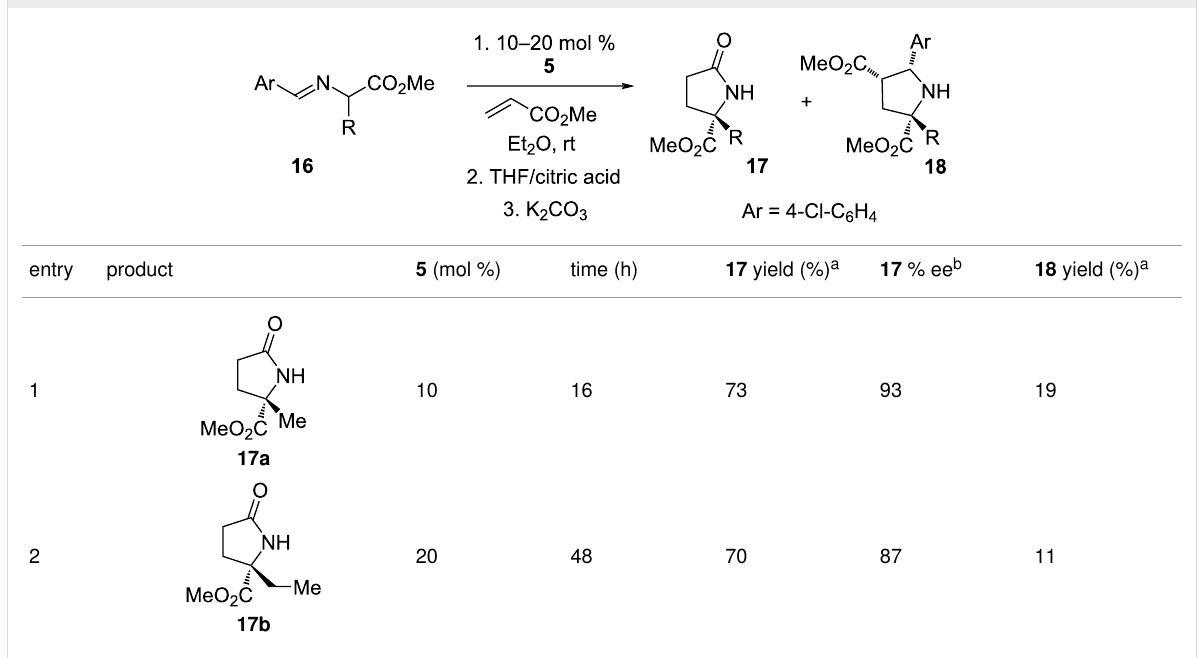
Table 2: Substrate scope of amino ester imine additions to methyl